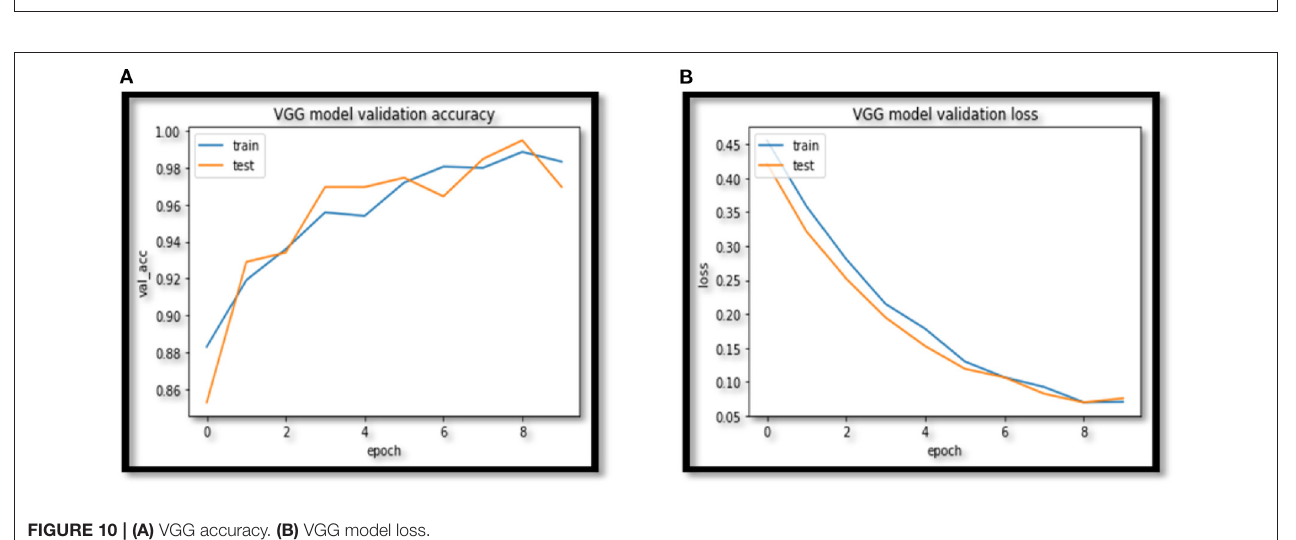
FIGURE 10 | (A) VGG accuracy. (B) VGG model